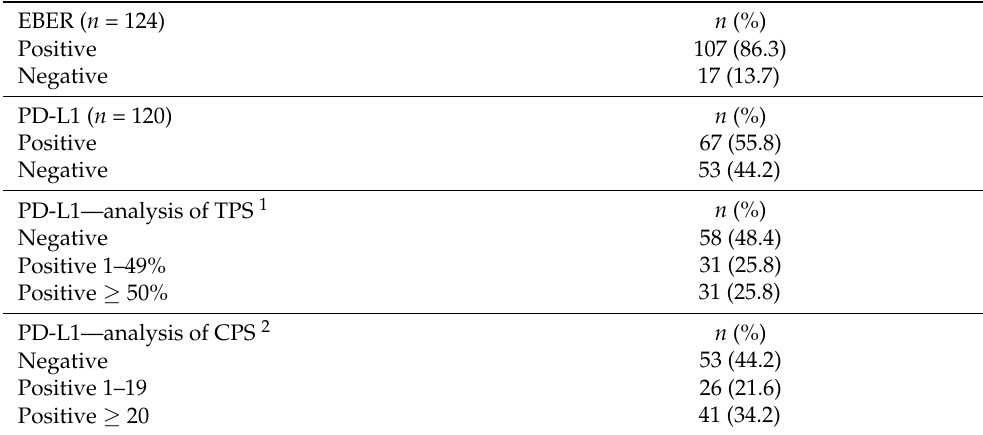
Table 3. Analysis of EBER * and PD-L1